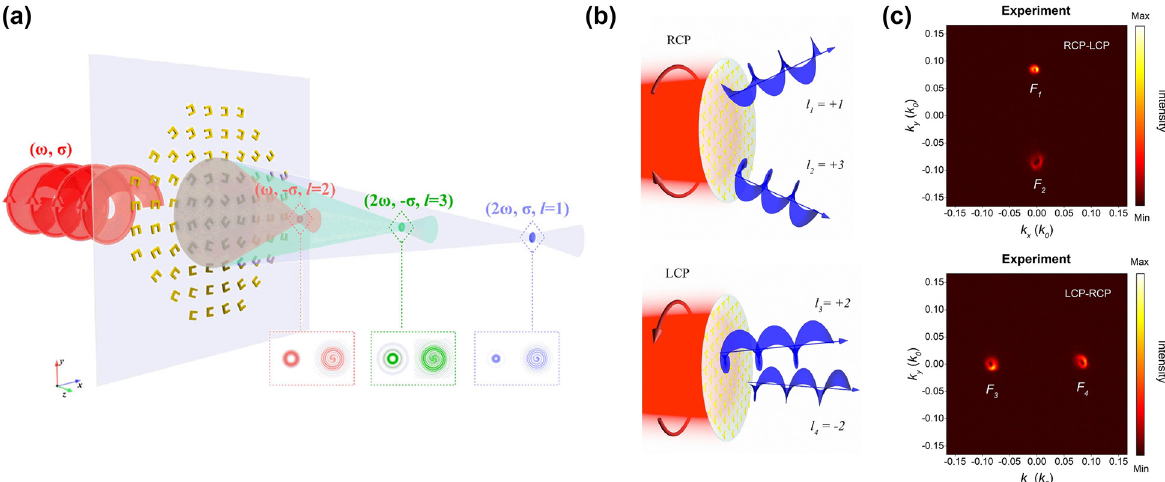
Figure 7: Nonlinear metasurface for OV generation and manipulation. (a) Schematic of the nonlinear multifunctional metasurface that can generate three focused OVs with different topological charges and different focal lengths [109]. (b) Schematic of the spin-controlled nonlinear metasurface that can generate nonlinear OVs with independent topologicalchargesforLCPandRCPlight[27].(c)ThemeasuredLCPandRCPlightintensitydistributionsofSHGsignalsin k -spaceforRCPand LCP incident light